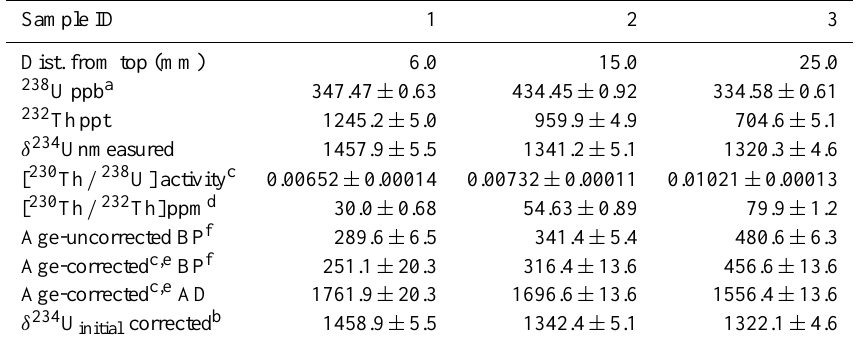
Table 1. U-series isotopic results and ages for stalagmite ky1 from Kaiyuan Cave–Shandong Peninsula–northern China.